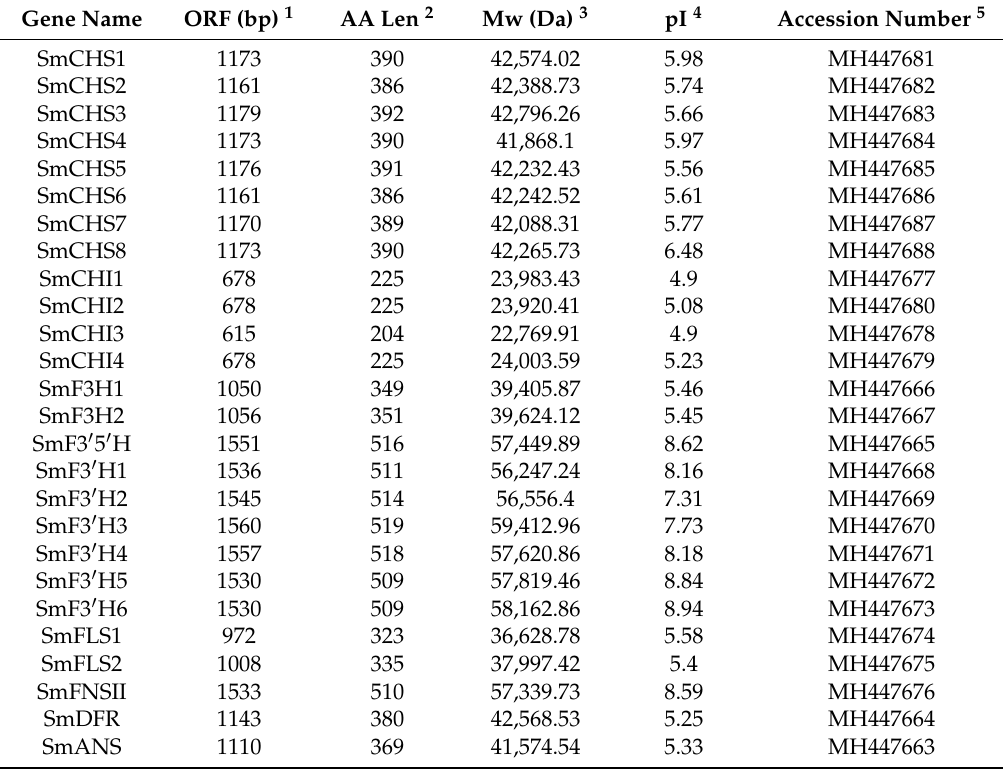
Table 1. Sequence features of flavonoid biosynthesis-related genes in S. miltiorrhiza